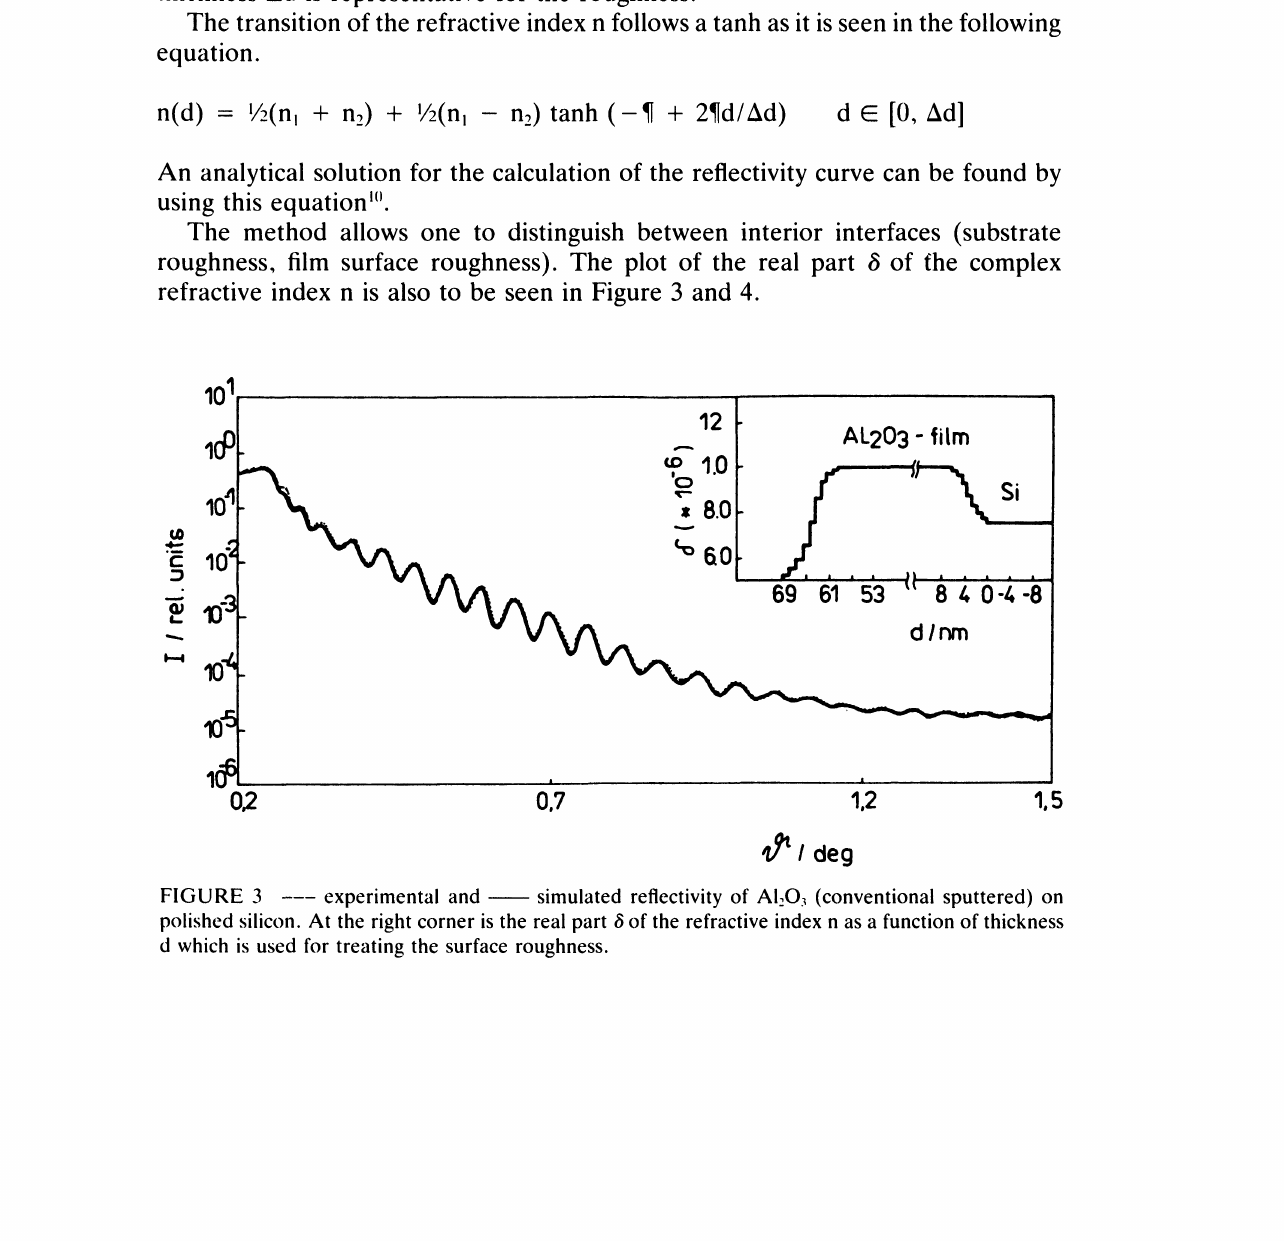
FIGURE 3 experimental and simulated reflectivity of Al:O3 (conventional sputtered) on polished silicon. At the right corner is the real part of the refractive index n as a function of thickness d which is used for treating the surface